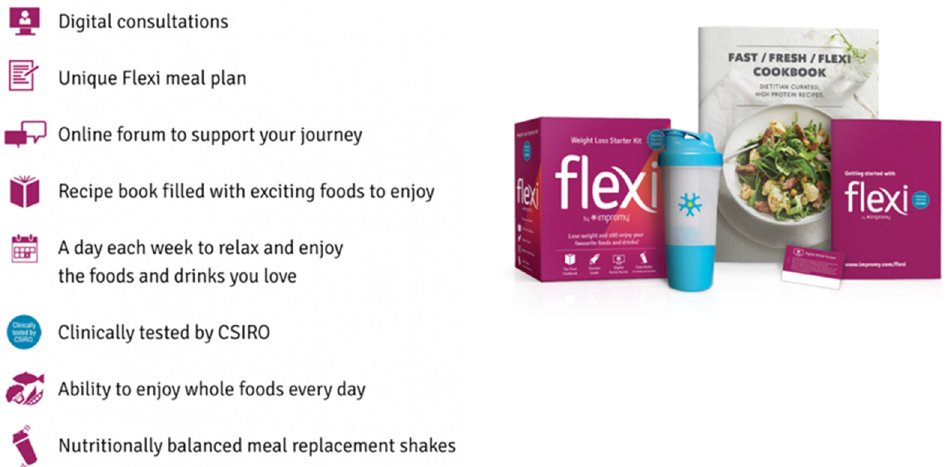
Figure 1: Partial Meal Replacement